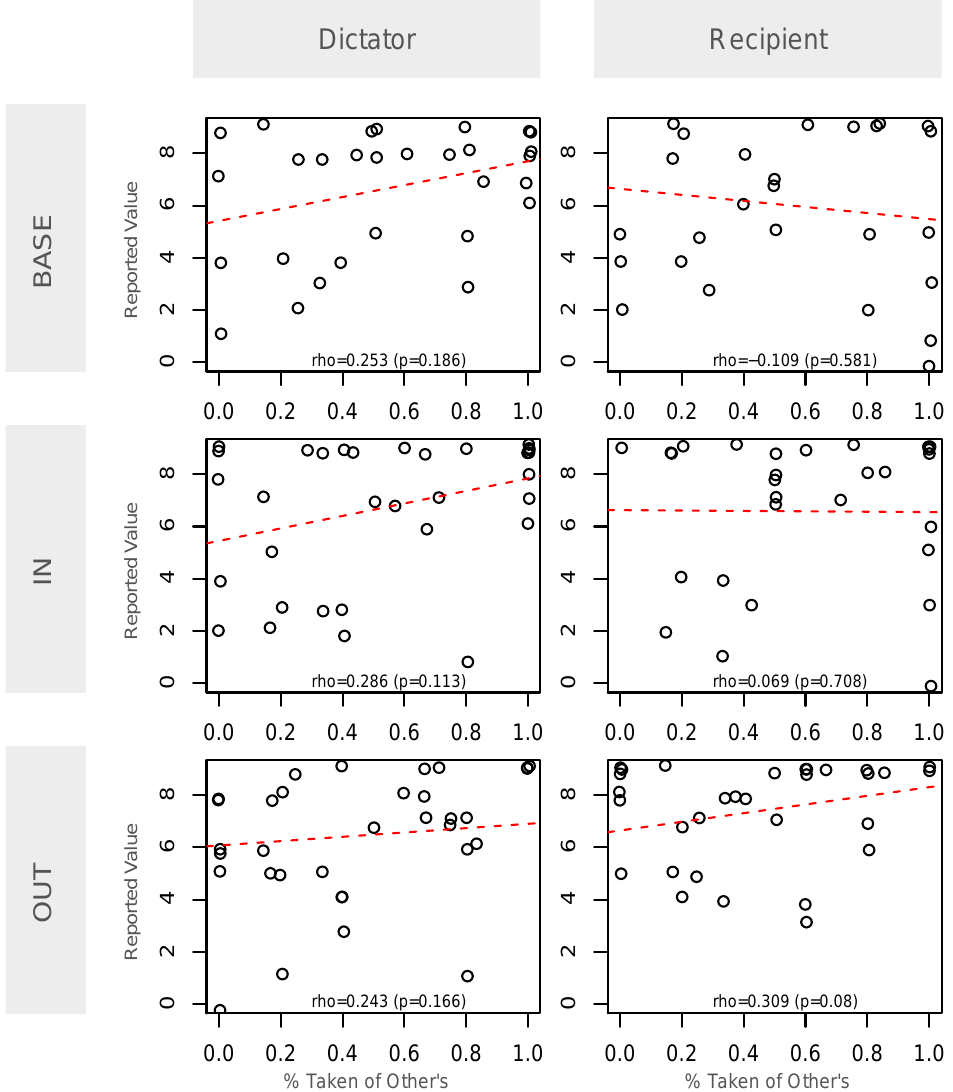
Figure 3. Self-reported numbers and unfairness. On the x -axis, the proportionality index φ = π D − e D On the y -axis, the value reported in the dishonesty task. For dictators, higher values on the horizontal axis imply more unfairness favoring them. Conversely, for recipients, higher values on the horizontal axis imply more unfairness damaging them. In each panel, a Spearman’s rank correlation ρ is